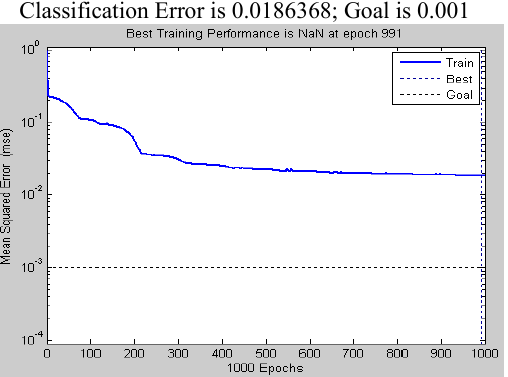
Fig. 2: Learning Rate of a Back Propagation Fig. 2 shows the convergence of the back propagation algorithm